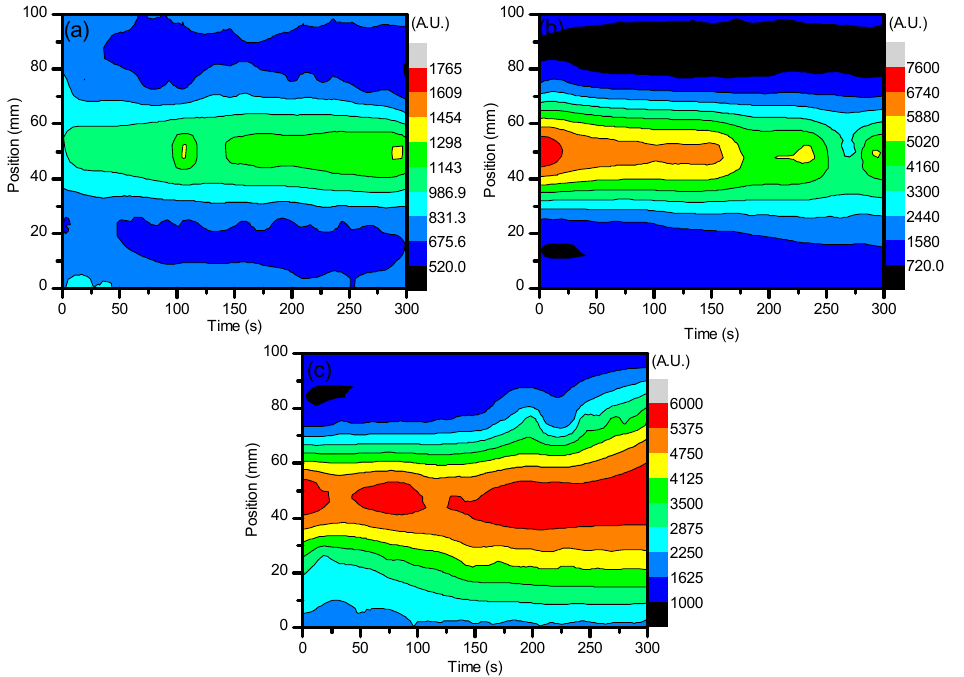
Figure 7. The formation of OH as detected by OES when the ambient air introduced to the system contained ≈ 3.8% CO 2 . ( a – c ) represent voltages 27 kV, 29.6 kV, and 32 kV, respectively.